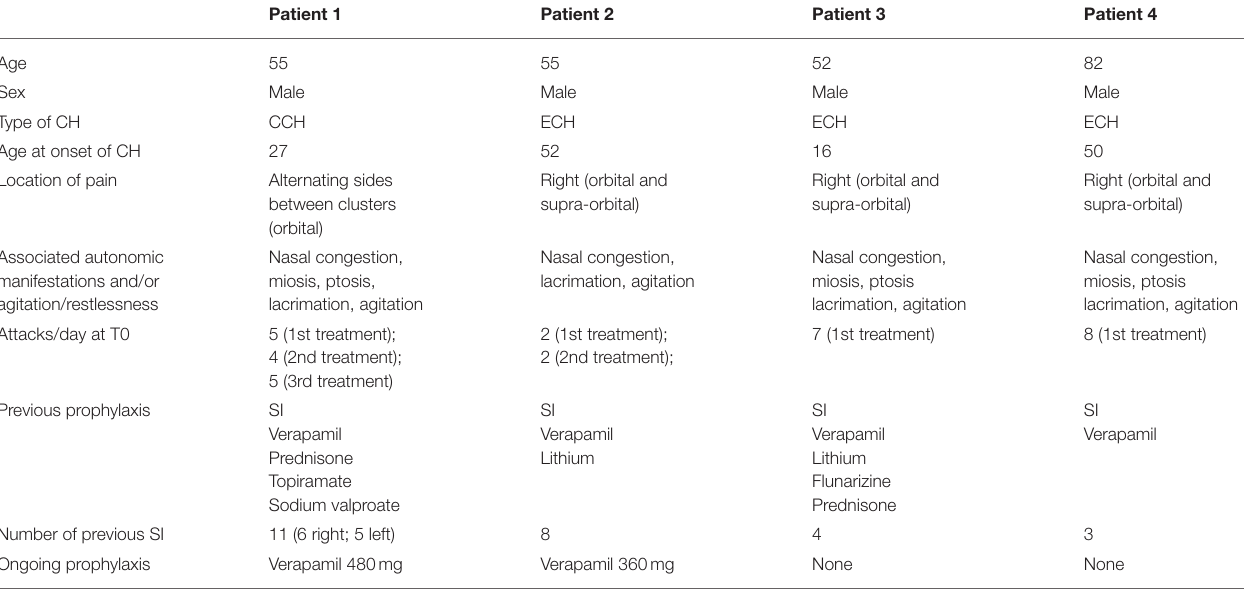
TABLE 1 | Demographic data, headache characteristics.